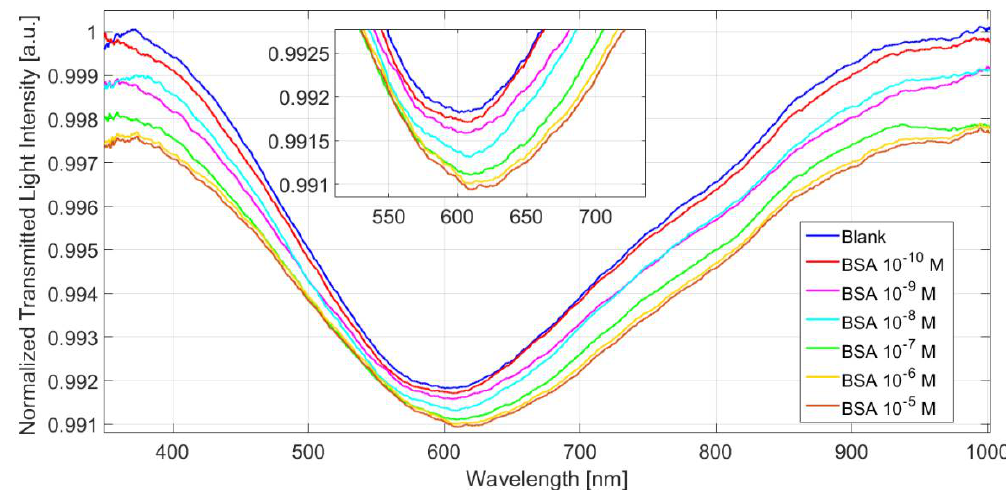
Figure 3. Normalized SPR transmitted spectra at varying bovine serum albumin (BSA) protein concentrations (0–10 − 5 M). Inset: zoom of the resonance wavelength area.